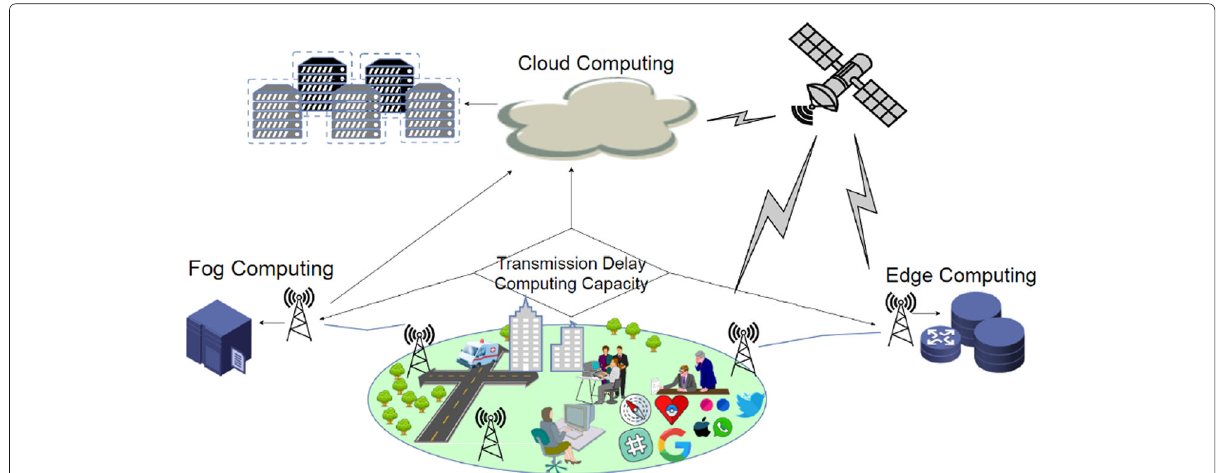
Fig. 2 Framework for cloud-fog-edge computing in